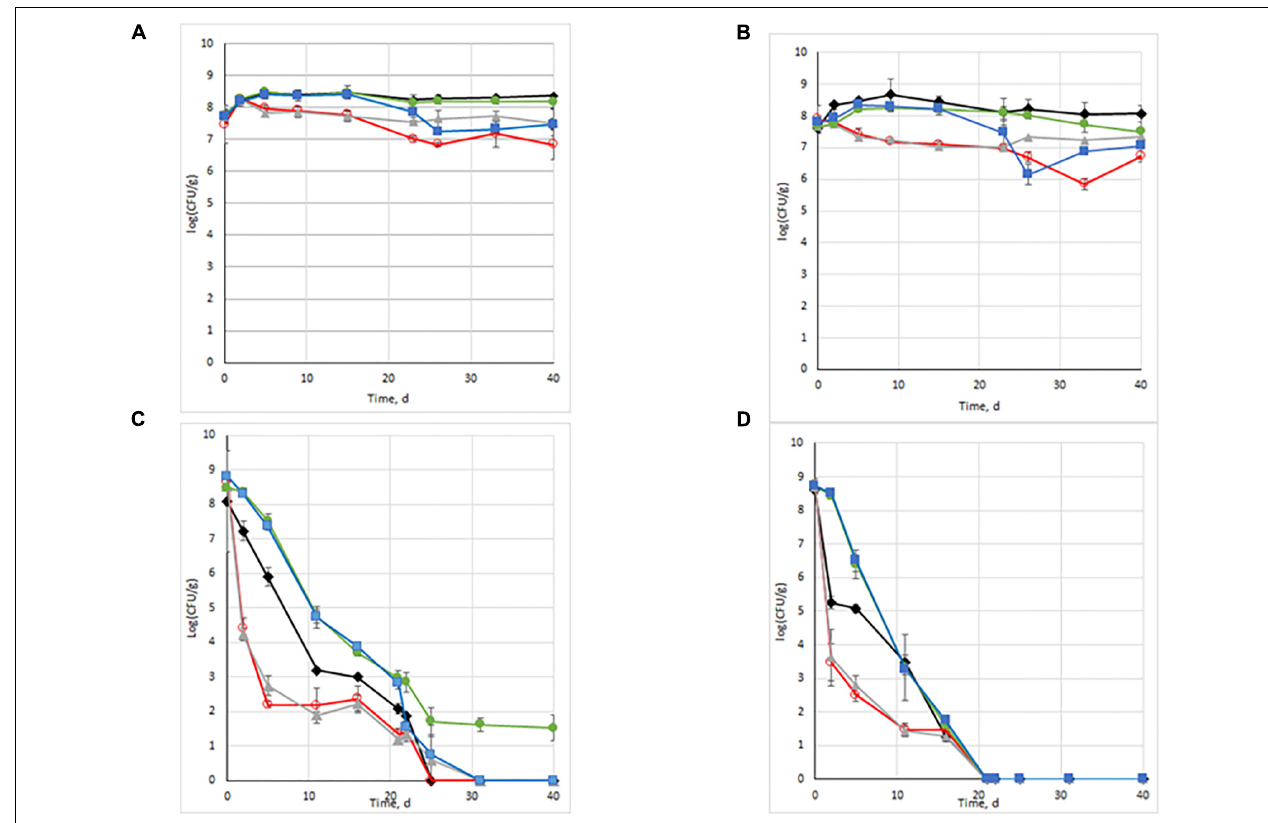
FIGURE 2 | Persistence dynamics of Listeria monocytogenes populations in control and in microcosms undergoing disturbances. (A) sterilised soil E microcosms; (B) sterilised soil D microcosms; (C) non sterile soil E microcosms; (D) non sterile soil D microcosms. (cid:7) : Control; (cid:13) : Heat T0 /Heat T20 ; (cid:78) : Heat T0 /Cold T20 ;